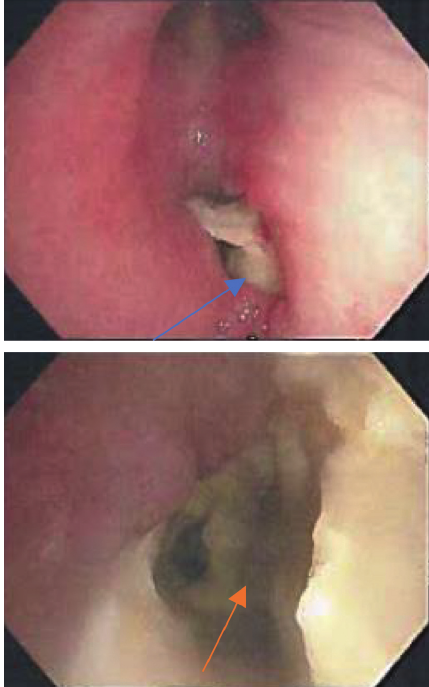
Figure 2: Solid obstructing endobronchial aspergilloma (blue arrow) in the right bronchus intermedius extending distally (or- ange